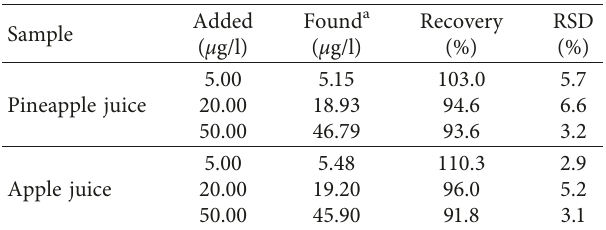
Table 2: Recoveries of FA in fruit juices by CdTe-QDs@MIPs- based sensor ( n � 3 ) . Sample